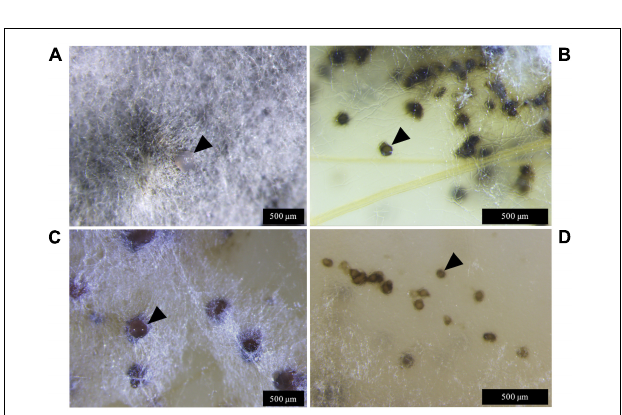
FIGURE 3 | Zymoseptoria tritici IPO323 and the (cid:49) ztvelB mutant pycnidia on wheat extract agar (WEA) at 20 ◦ C under LD conditions at 69 days post-inoculation. Images representative of three independent (cid:49) ztvelB strains tested across two experiments. (A) The IPO323 strain forms white aerial hyphae from a melanised based from which hyaline cirrhus is produced (indicated by arrowheads). (B) Develops spherical black/brown pycnidia beneath the surface of the agar (indicated by arrowheads). (C) The (cid:49) ztvelB mutants form white aerial hyphae with large abnormal pycnidia-like structures on the surface of the agar. The pycnidia-like structures exude clear droplets (indicated by arrowheads). (D) The (cid:49) ztvelB mutants also form pycnidia-like structures similar to IPO323 beneath the surface of the agar (indicated by